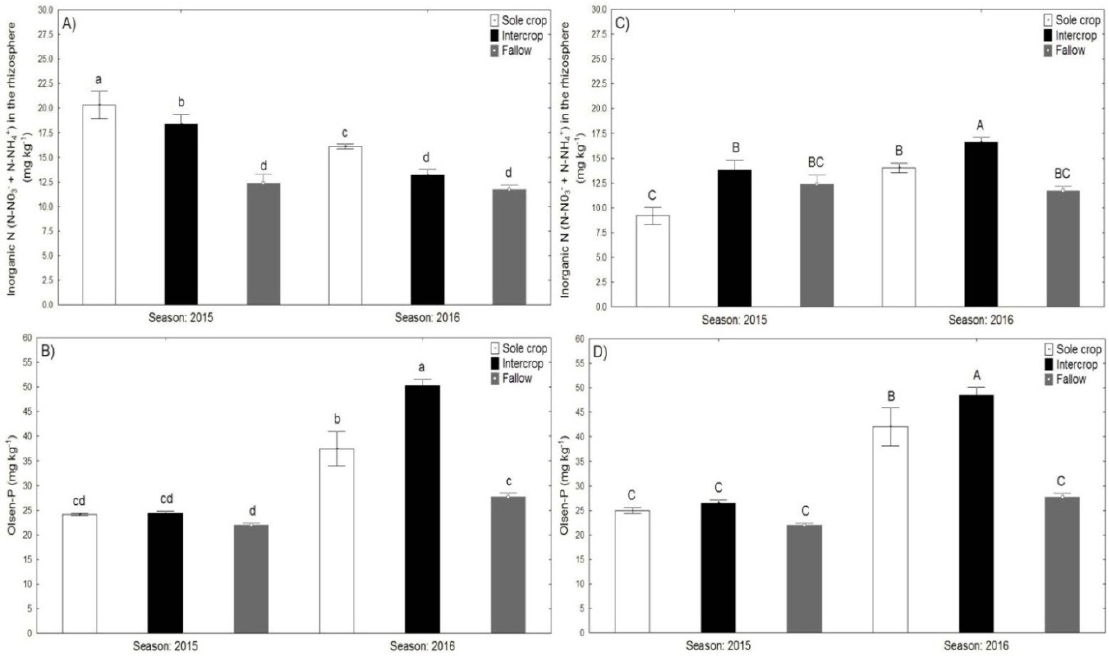
Figure 6. Inorganic N (N-NO 3 − + N-NH 4 + ) and Olsen P in the rhizosphere of chickpea ( A , B ) and durum wheat ( C , D ) as sole crops and intercrops and for the fallows. Data are means and SE of 12 rhizosphere samples taken 120 days after sowing. Bars with the di ff erent letters compare cropping systems and years within a crop and are significantly di ff erent at p < 0.05.